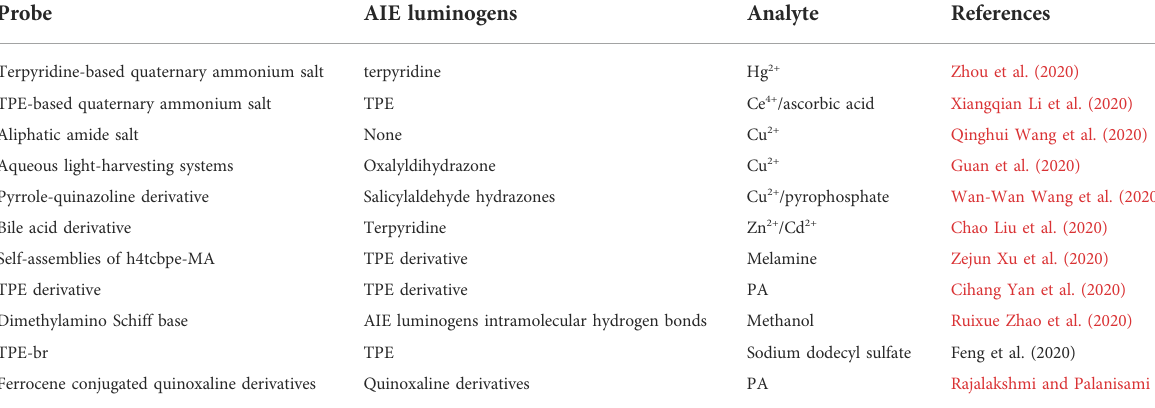
TABLE 1 AIE-based fl uorescent chemosensor for detecting of analytes. Probe